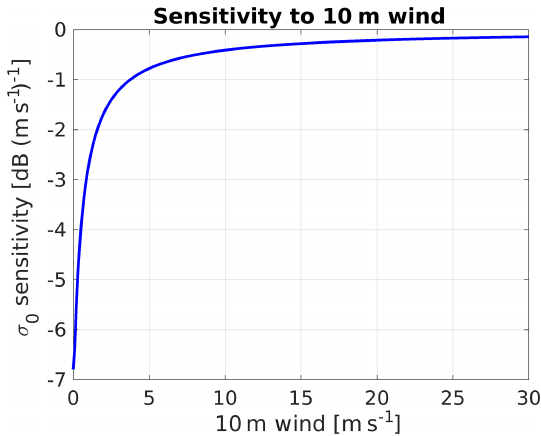
Figure 6. Sensitivity of the normalized radar cross section, σ 0 , to 10m wind speed according to the Wu (1990)